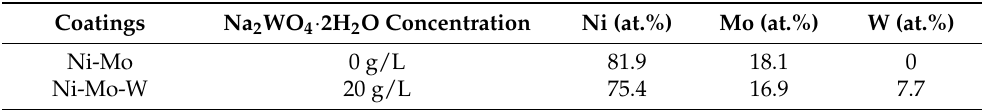
Table 1. The concentration of Na 2 WO 4 · 2H 2 O in plating bath and EDS analysis results of as-deposi- tion